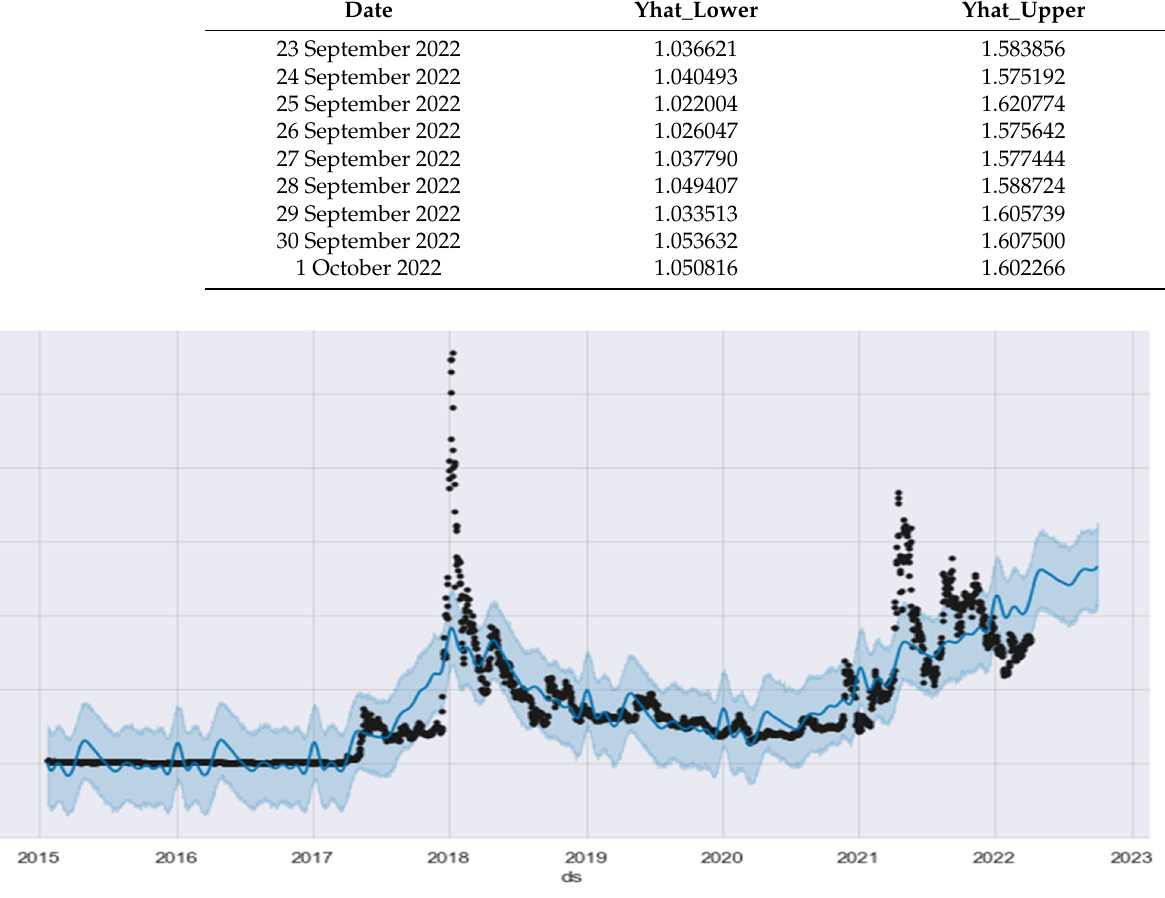
Figure 16. Future prices of the XRP cryptocurrency.